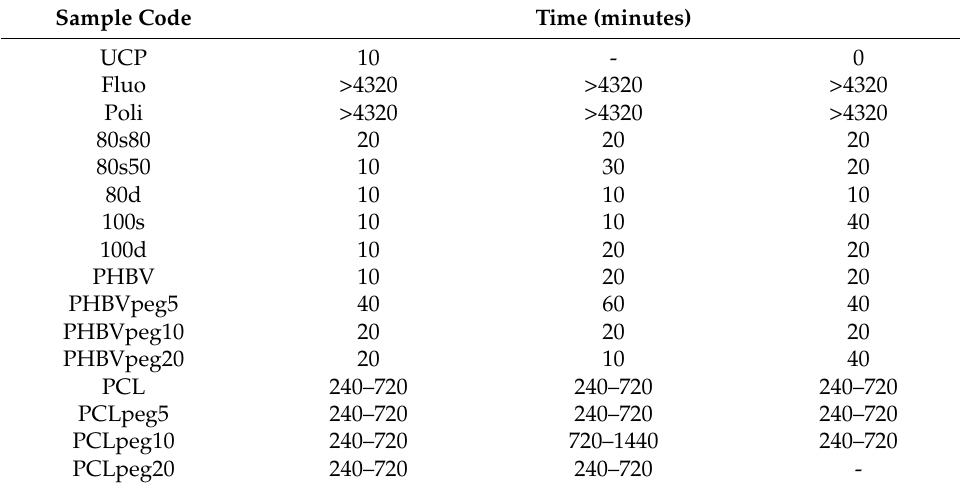
Table 3. Grease resistance times.